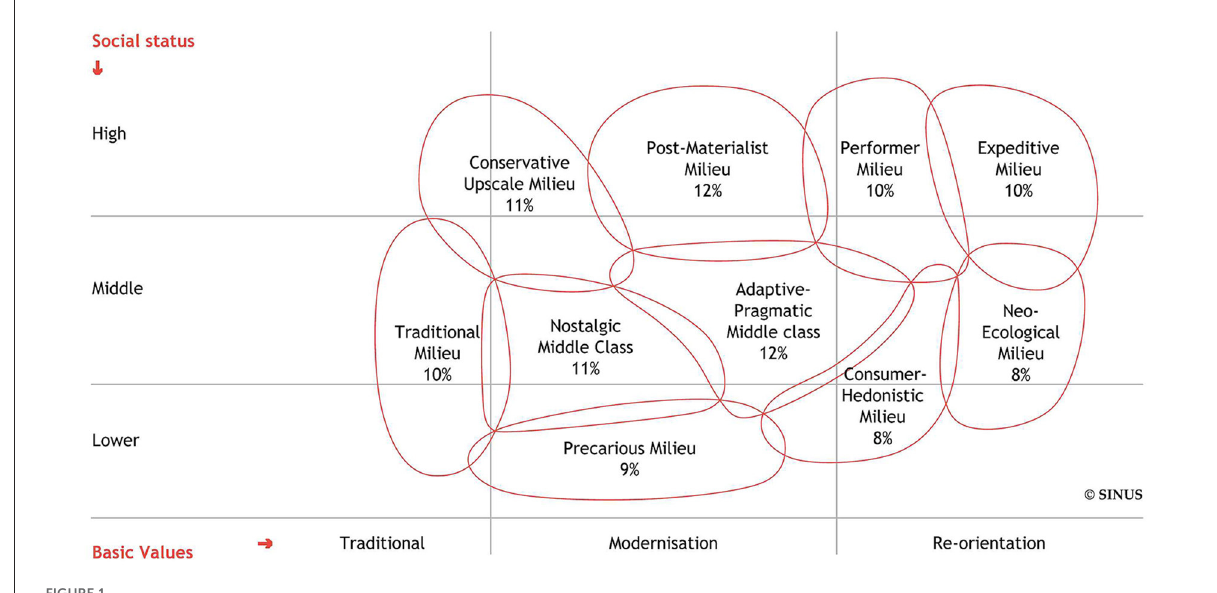
FIGURE1 Sinus ® milieus. Source: Sinus ® Institute.